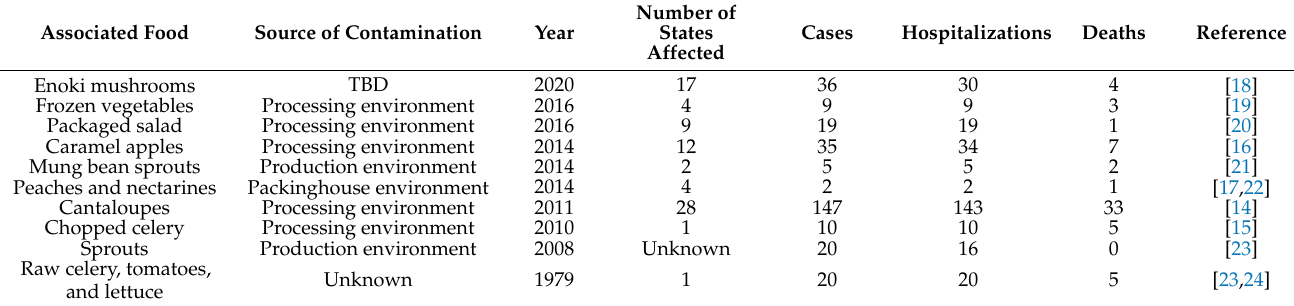
Table 1. U.S. listeriosis outbreaks associated with fresh